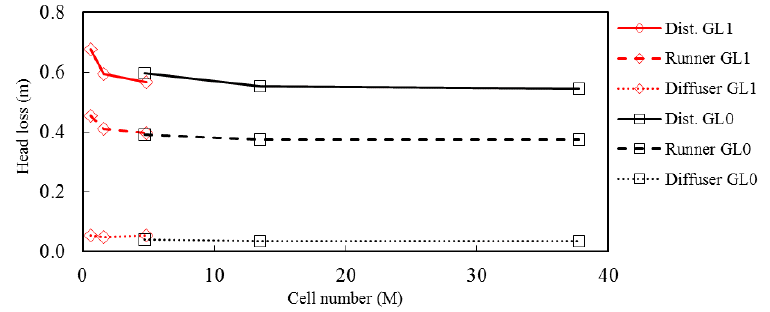
Figure 10. Head losses in the turbine for the three mesh densities at two different grid levels [16]. The three curves represent a mesh sensitivity analysis of the distributor ( upper ); runner ( middle ); and diffuser ( lower ), respectively.